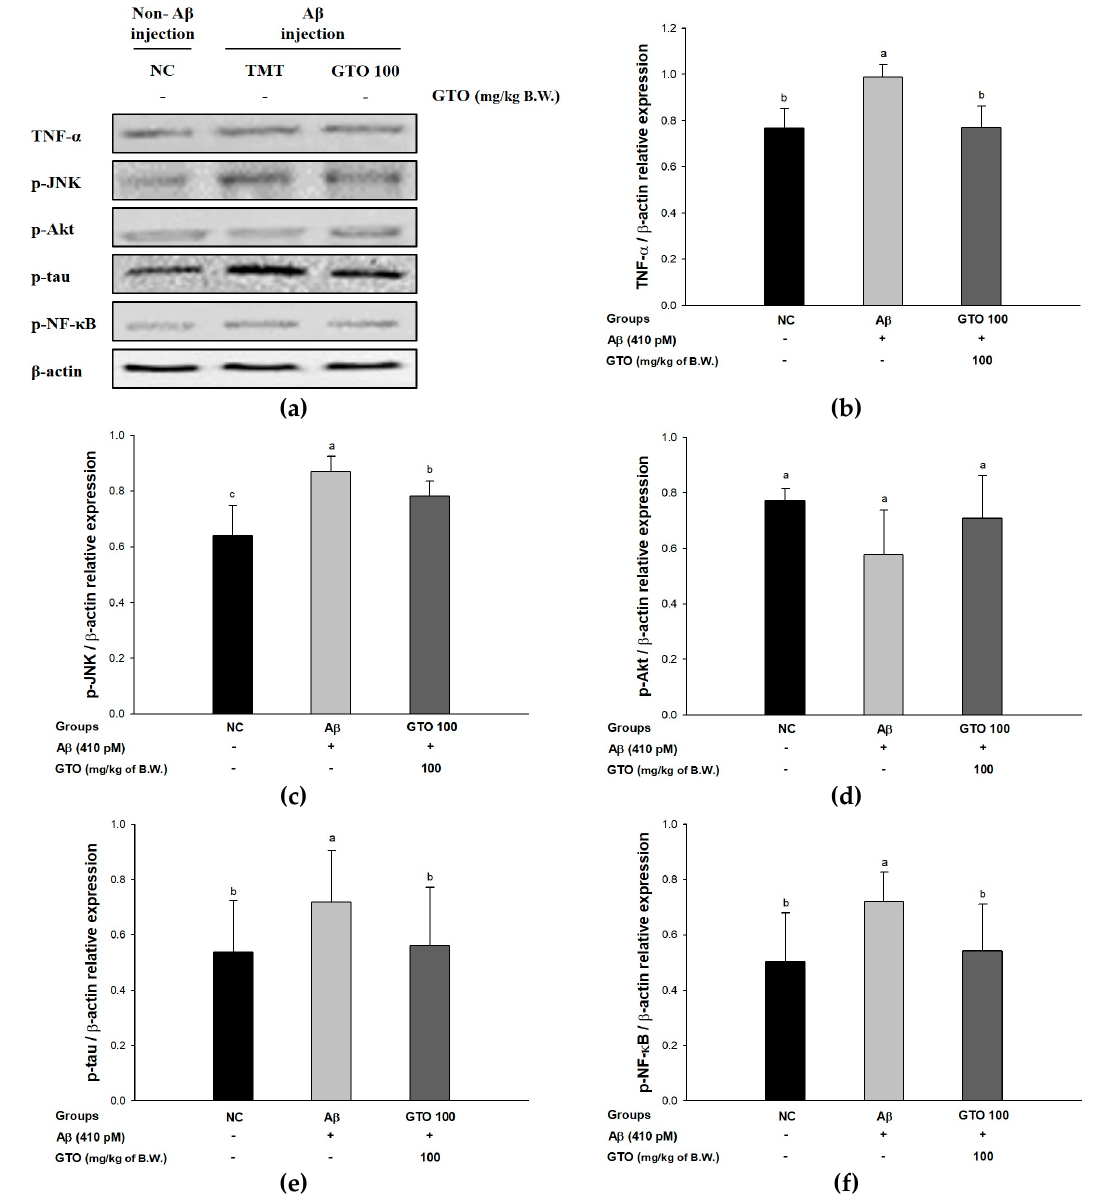
Figure 7. Ameliorating effect of green tea seed oil (GOT) on A β -related JNK/Akt pathway in mice brain tissues. ( a ) Representative Western blots for total protein and expression of TNF- α , p-JNK, p-Akt, p-tau, p-NF- κ B and β -actin. The protein expression levels of TNF- α ( b ); p-JNK ( c ); p-Akt ( d ); p-tau ( e ) and p-NF- κ B ( f ). Results shown are mean ± SD ( n = 3). Data were statistically represented at p < 0.05, and different lowercase letters indicate statistical significance. NC: A β − /sample − group; A β : A β + /sample − group; GTO 100: A β + /GTO (100 mg/kg of body weight) + group. B.W.: body weight.